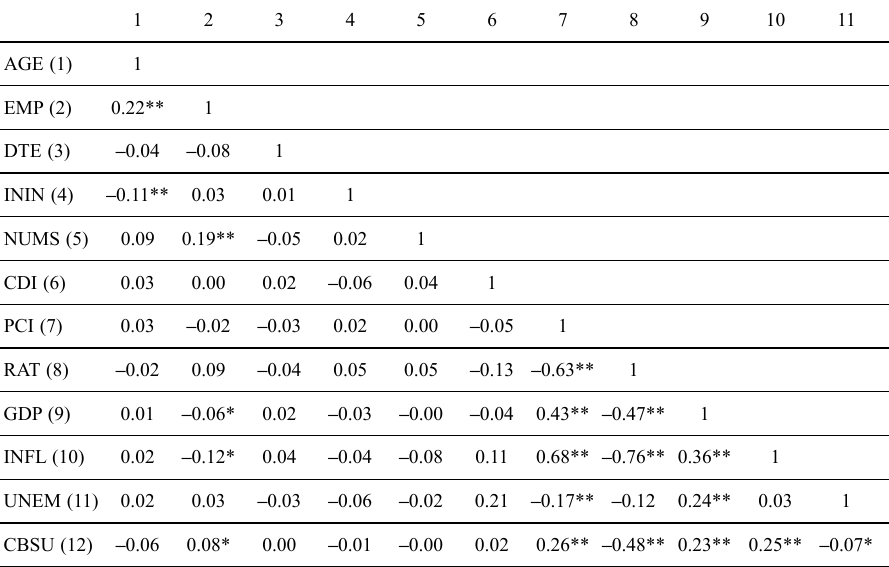
Table 3. Correlation matrix of